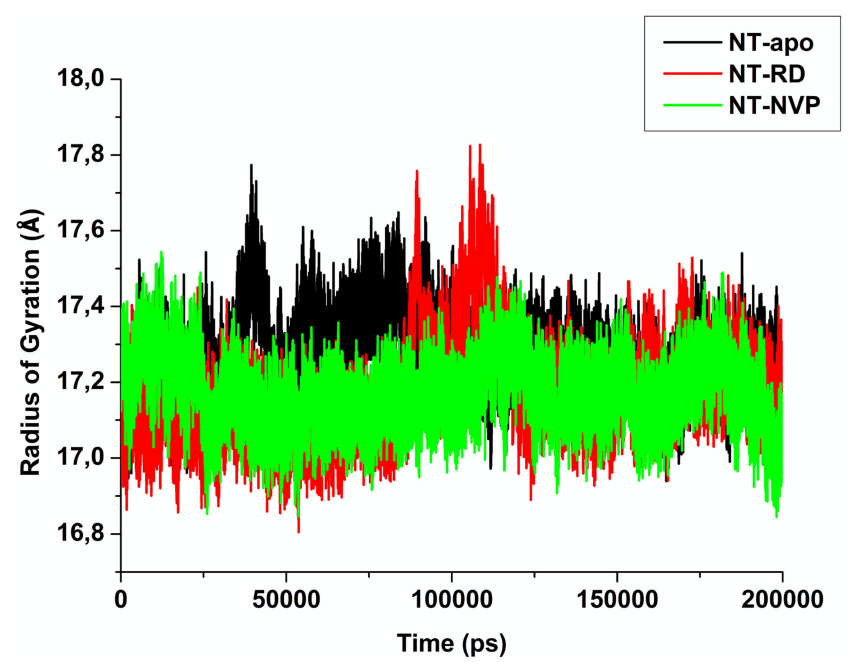
Figure 8. The RoG of NT-apo, NT-RD and NT-NVP recorded over 200000 ps MD simulation.